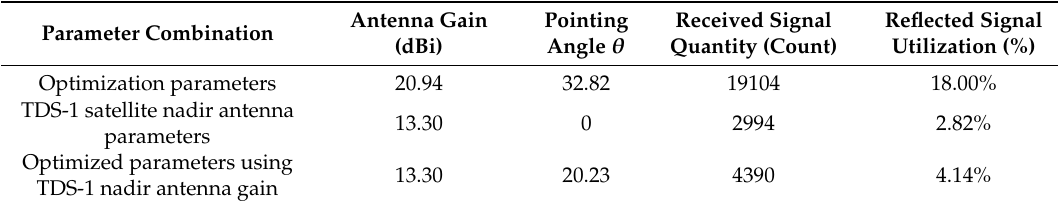
Table 4. Received signal quantity and utilization under the comprehensive sea